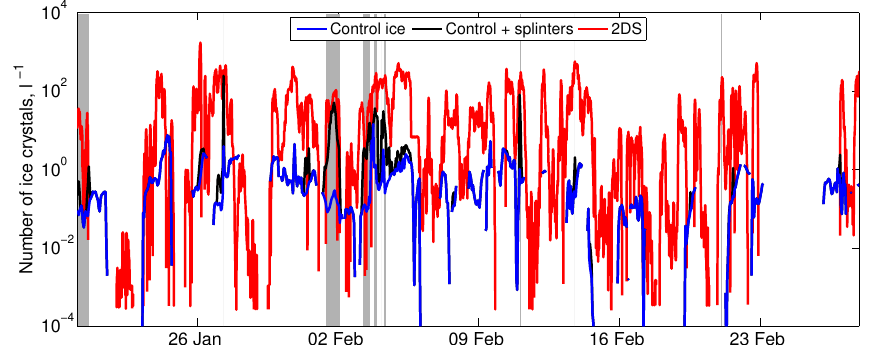
Figure 8. Comparison of ice number concentrations from the WRF control simulation, the control simulation with the addition of rime splin- ters produced by the Hallett–Mossop process calculated using Eq. (4), and the 2D-S probe at Jungfraujoch during the INUPIAQ campaign. The grey-shaded areas indicate periods where the ice number concentration including the splinters is at least a factor of 10 greater than the concentration from the WRF control simulation.